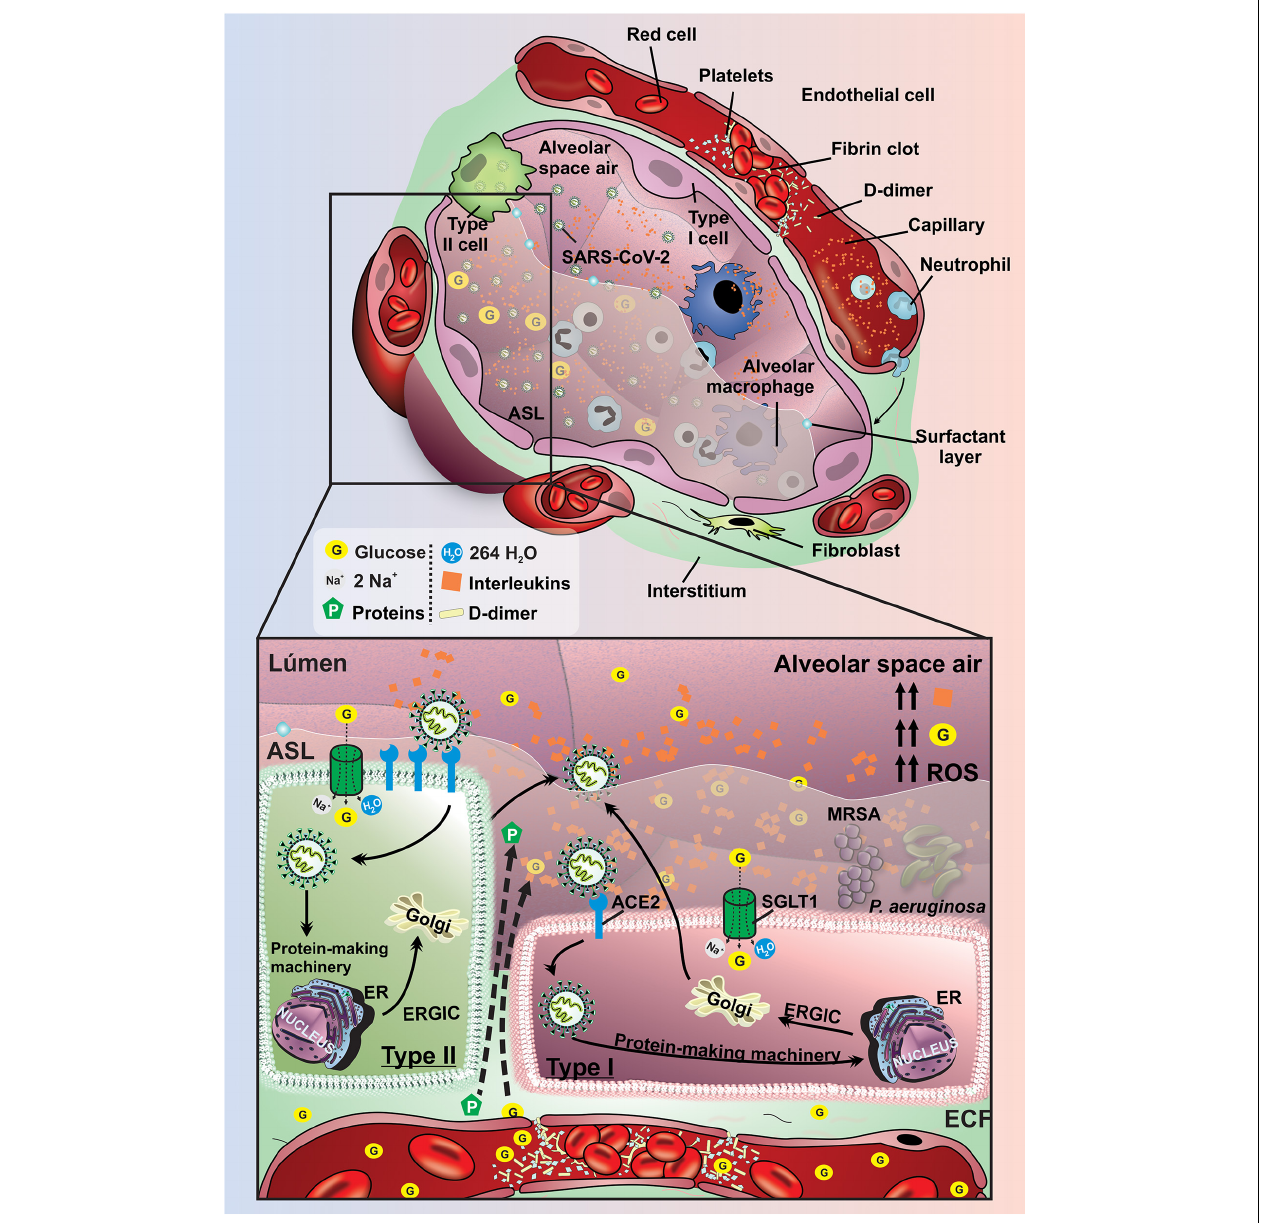
FIGURE 5 | Pathological manifestations of lung tissue in diabetic patient affected by SARS-CoV-2. Schematic representation of pathophysiological mechanisms related to SARS-CoV-2 infection in the lung of diabetic subjects. Spike glycoproteins from the SARS-CoV-2 envelope binds to ACE2 allowing the inoculation of the viral genome into type I and II pneumocytes. The virus uses the host cells machinery to replicate and infect other cells which can result in the activation of a disseminated inflammatory cascade. The high concentration of glucose and the increased volume in the ASL are maintained mainly by the low expression of SGLT1 in the apical membrane of type I and II pneumocytes in the condition of DM. These changes promote a potential increase in the production of interleukins, activation of ROS, damage to the alveolar epithelium and endothelium, which allows the leakage of liquid and glucose from the interstitial to the alveoli. In addition, the risk of developing pneumonia due to the proliferation of P. aeruginosa and MRSA bacteria is greatly increased in diabetic individuals with COVID-19. G, glucose; SGLT1, Na + /glucose/H 2 O type 1 cotransporter; ECF, extracellular fluid; ER, endoplasmic reticulum; ERGIC, endoplasmic reticulum-golgi intermediate compartment; ACE2, receptor angiotensin-converting enzyme 2; ROS, reactive oxygen species; P. aeruginosa , Pseudomonas aeruginosa ; MRSA, Methicillin-resistant Staphylococcus aureus ; Orange rhombus: